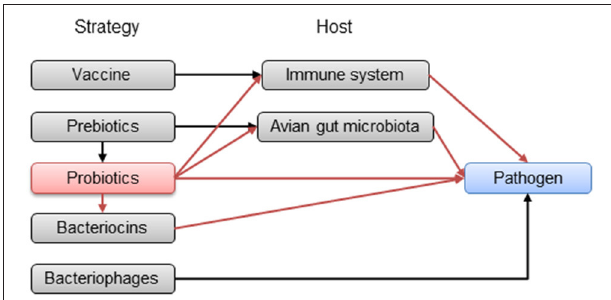
FIGURE 1 | Potential pathways of the strategies in progress to reduce avian gut pathogens in poultry. Red arrows represent probiotic